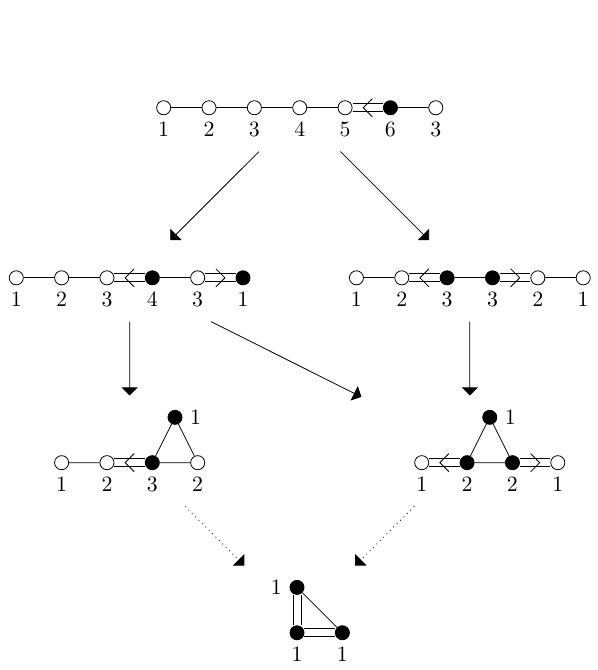
sp (8) f 4 series. − −